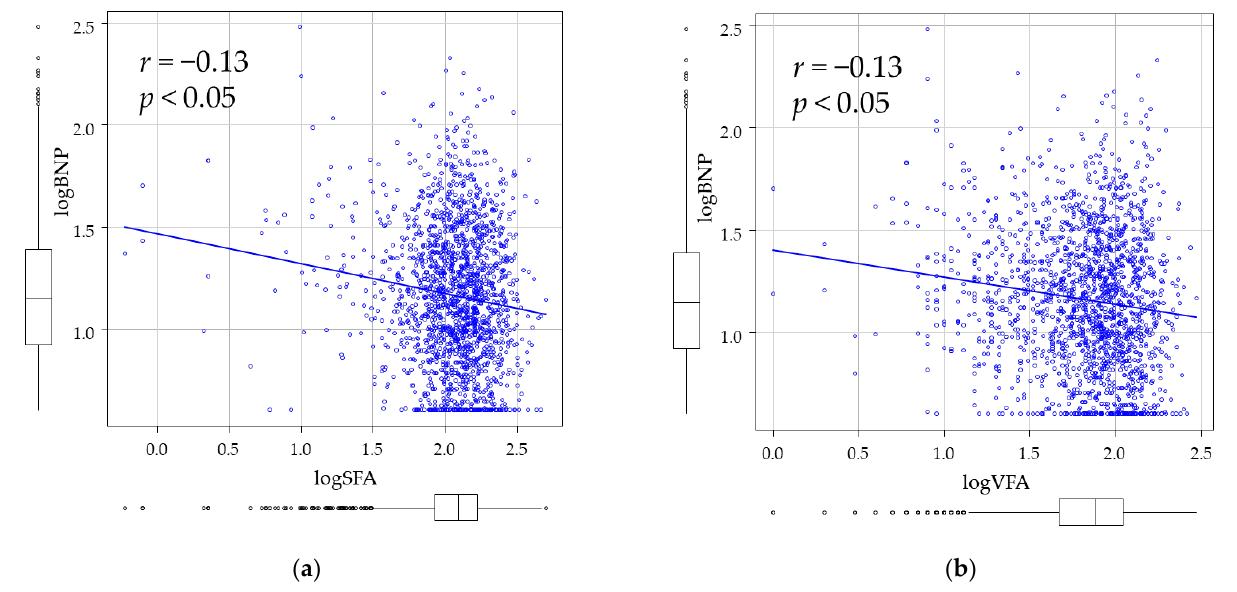
Figure 2. Correlation between logSFA, logVFA, and logBNP. Pearson’s correlation analysis was used to examine relationships between logSFA ( a ), logVFA and ( b ), logBNP.